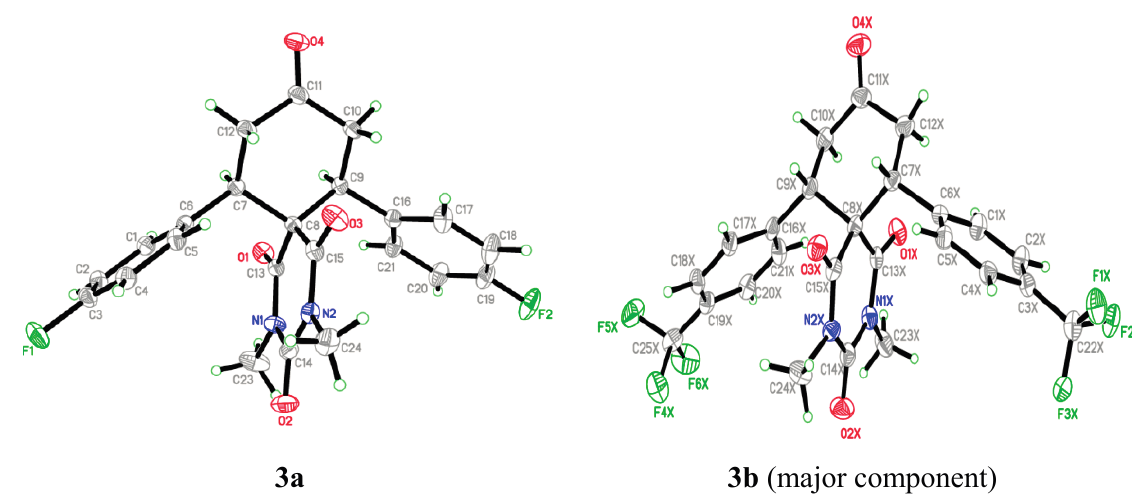
Figure 2. The ORTEP diagram of the final X-ray model of compounds 3a , b with displacement ellipsoids drawn at 30% probability level. The minor disorder component of compound 3b is omitted for clarity.